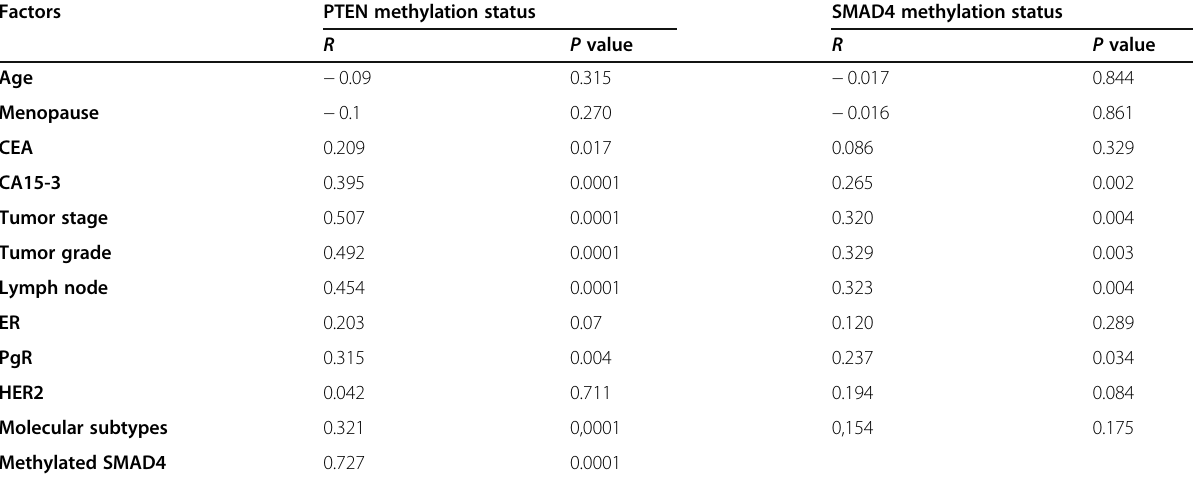
Table 2 Correlation between methylated PTEN and SMAD4 with other parameters